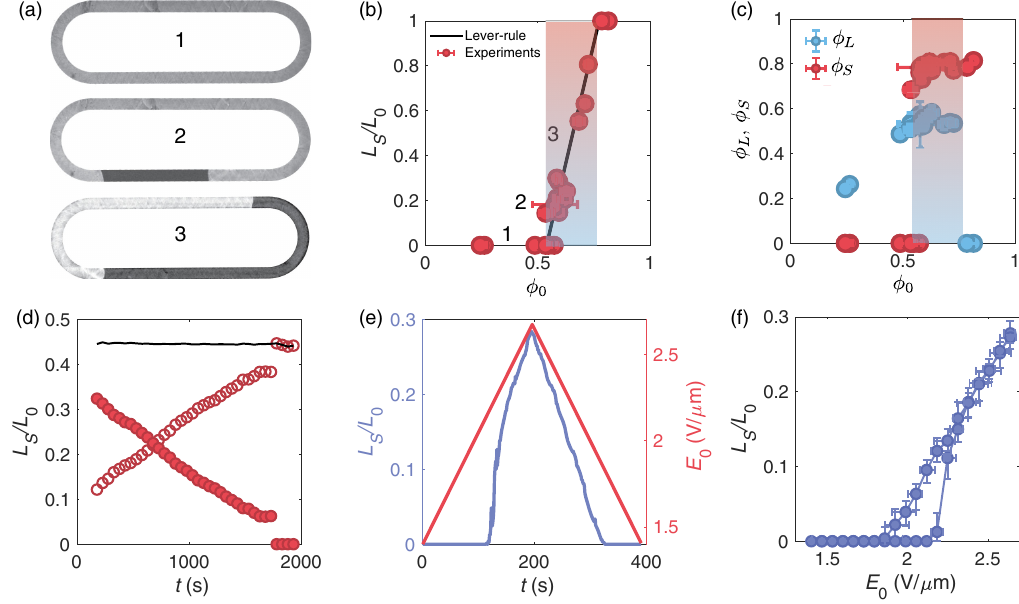
FIG. 3. Active solidification is a first-order phase separation. (a) Solid jams in a racetrack at ϕ 0 ¼ 0 . 38 , 0.58, 0.65. Increasing the average packing fraction, the extent of the active solid increases. (b) Solid fraction plotted versus the average packing fraction ϕ 0 . Note the discontinuous jump and the two possible states at the onset of solidification. (c) Density of the polar-liquid phase (blue circles) and of the active-solid phase (red circles) plotted versus ϕ 0 . In steady state, the liquid density increases with ϕ 0 until an active solid forms, the density in both phases then remains constant. In (b) and (c) the shaded regions indicate the coexistence between the polar-liquid and active-solid phases. (d) Coarsening dynamics. Two solid jams coexist only over a finite time period. The larger jam (filled symbols) shrinks and eventually vanishes in favor of the smaller one (open symbols). The total fraction of solid phase in the racetrack (black line) remains constant over time. (e) Solid fraction (blue line) and magnitude of the electric field (red line) plotted versus time. Over a range of E 0 values, the active-solid fraction is different when increasing or decreasing the electric field. (f) The extent of the traffic jam follows a hysteresis loop when cycling the field